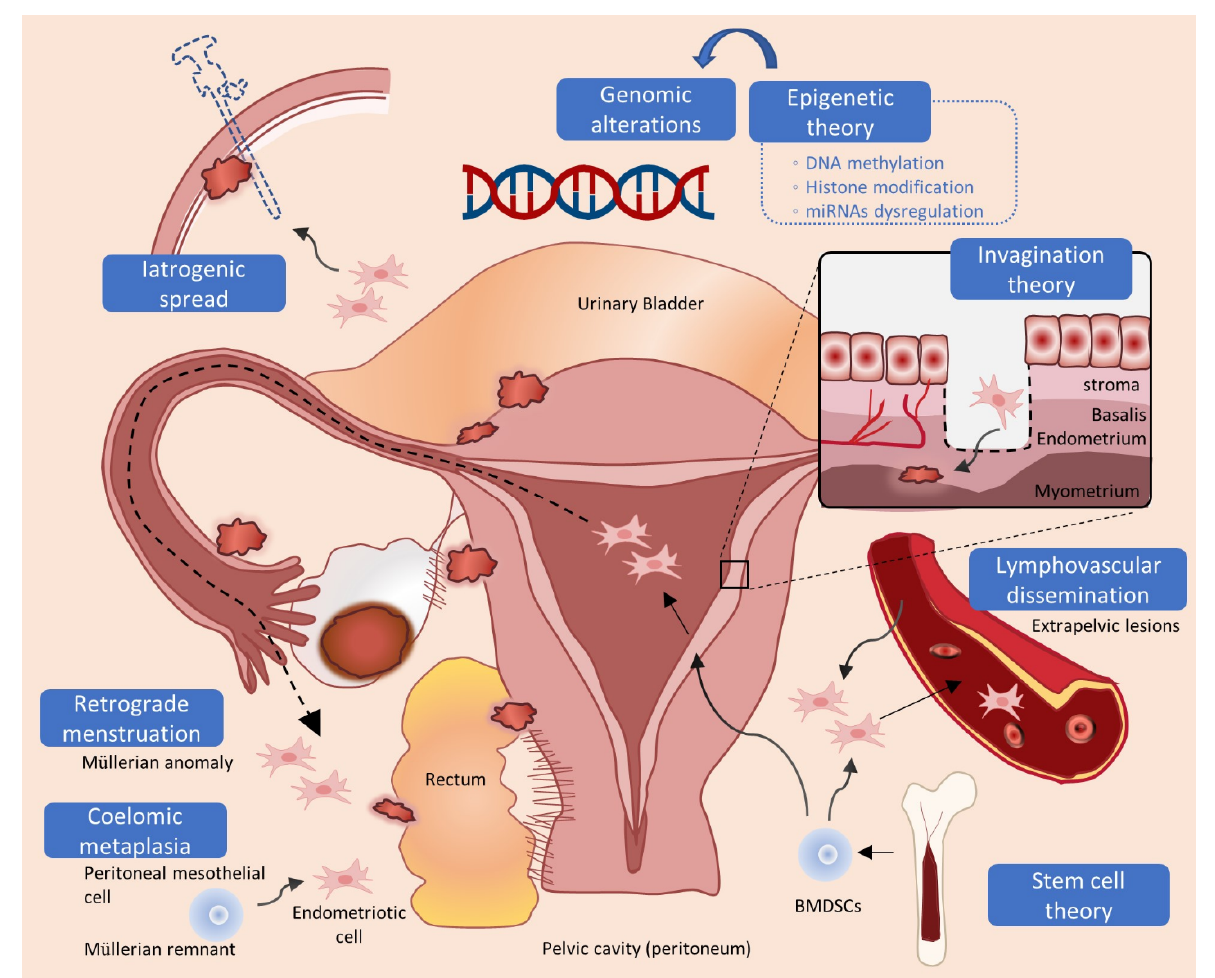
Figure 1. Theories of endometriosis pathogenesis. The potential origins of endometriotic lesions include traveling of endometrial tissue through retrograde menstruation and in situ by coelomic metaplasia of the peritoneal lining or from Müllerian remnants. Lymphovascular dissemination contributes to extra-pelvic lesions. Bone marrow-derived stem cells (BMDSCs) can directly differentiate into endometrial cells at ectopic locations in the peritoneal cavity and distant sites, further expanding the hypothesis of retrograde menstruation and lymphovascular dissemination. Invagination theory is characterized by altered endometrial basalis cells invading the uterine myometrium through disruption of the endometrial-myometrial interface (EMI), resulting in endometriosis of uterus. Epigenomic and genomic alterations further explain the aberrant gene expression in endometriotic lesions.